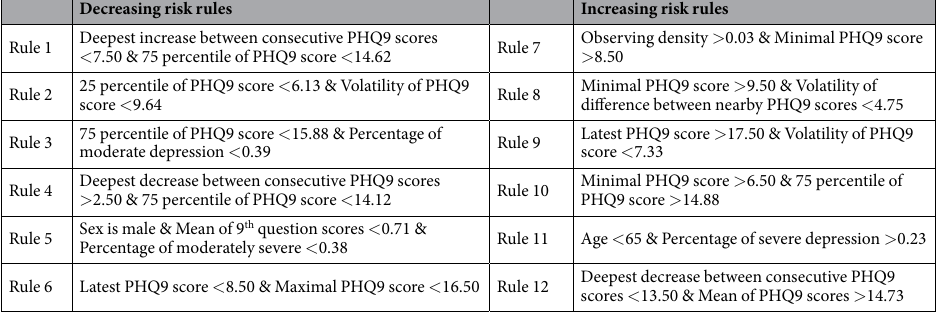
Table 2. 12 top rules identified by the RuleFit model. Note: the cut-off values of the variables in the rules were automatically determined by RuleFit for maximum statistical prediction power.